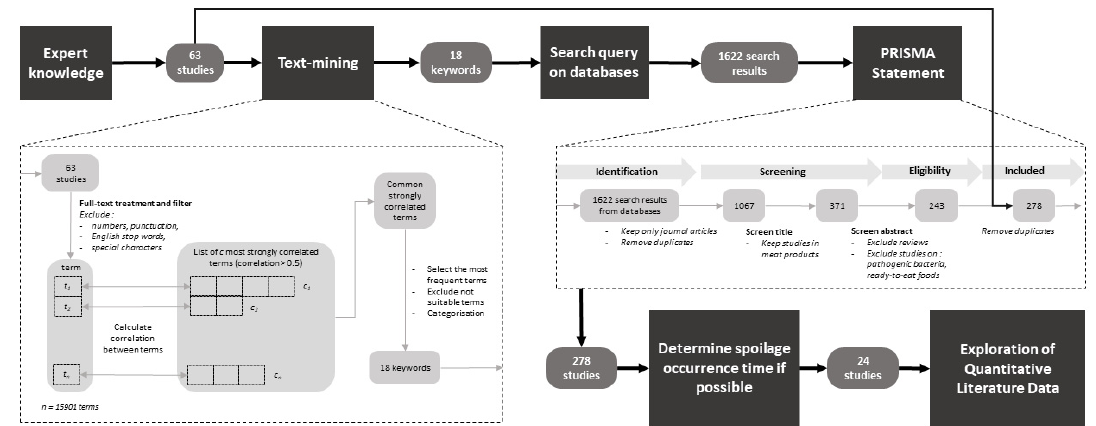
Figure 1. Flow chart outlining the procedure for quantitative data collection from the literature.